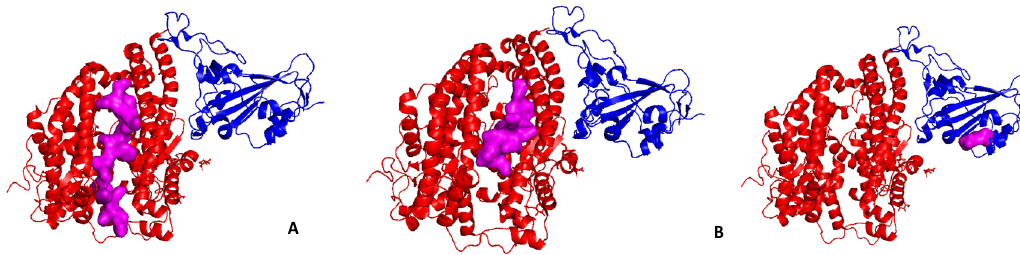
Figure 4. Molecular docking of selected peptides from Table 2 to the complex ACE2 – spike RBD; in purple, the peptide configuration and position upon docking. ( A ) Thunnus obesus ; ( B ) Palmaria palmata ; ( C ) Undaria pinnatifida .